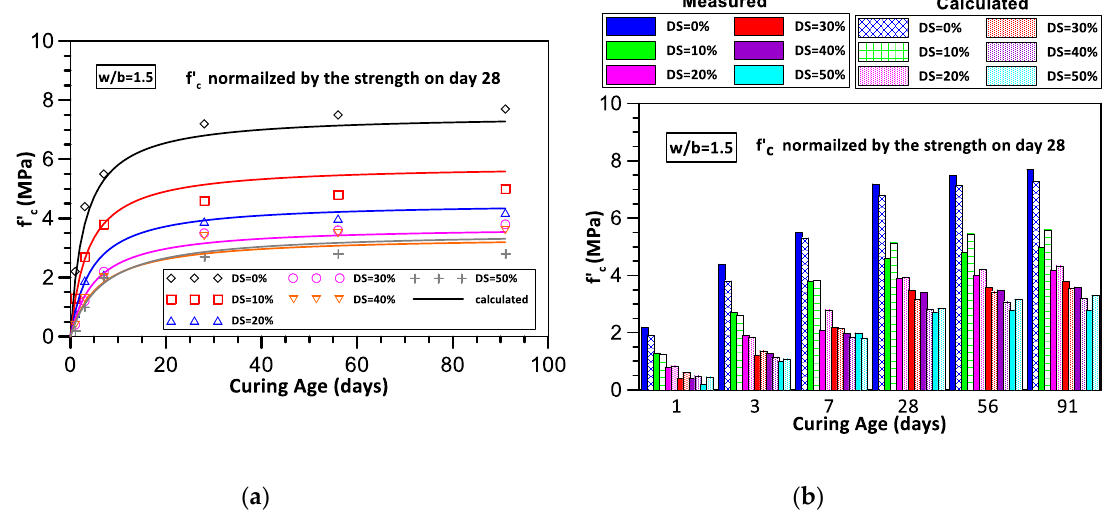
Figure 15. ( a ) Comparison of the compressive strength between the predicted analysis and test results. (by curve graph) ( b ) Comparison of the compressive strength between the predicted analysis and test results. (by histogram)